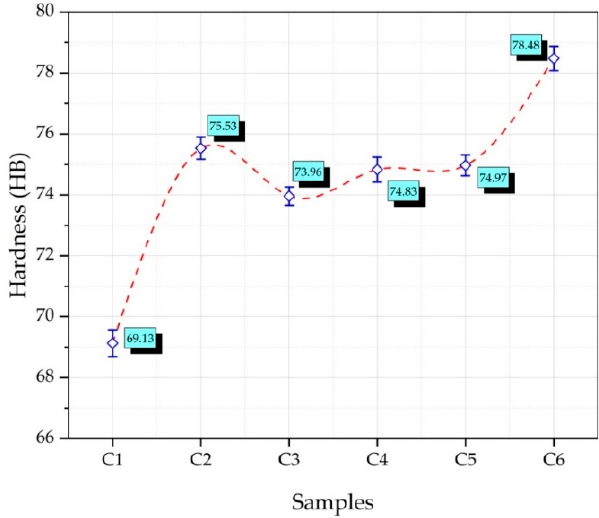
Figure 9. The resulting composite specimens’ macro hardness plot.